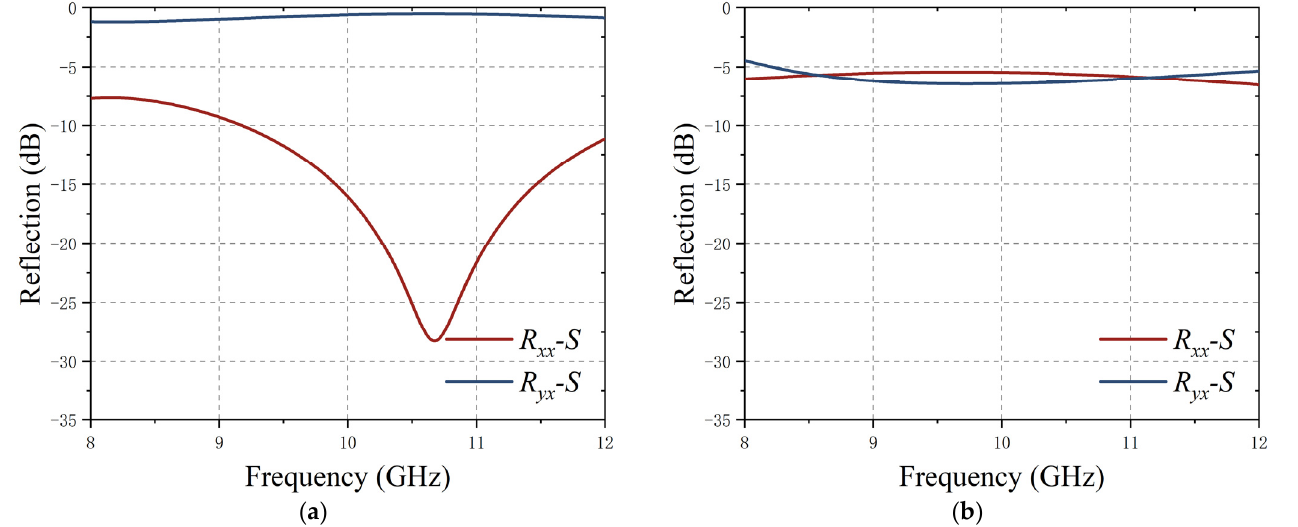
Figure 3. The simulated amplitude of reflective coefficients R xx and R yx . ( a ) Diodes off; ( b ) Diodes on.